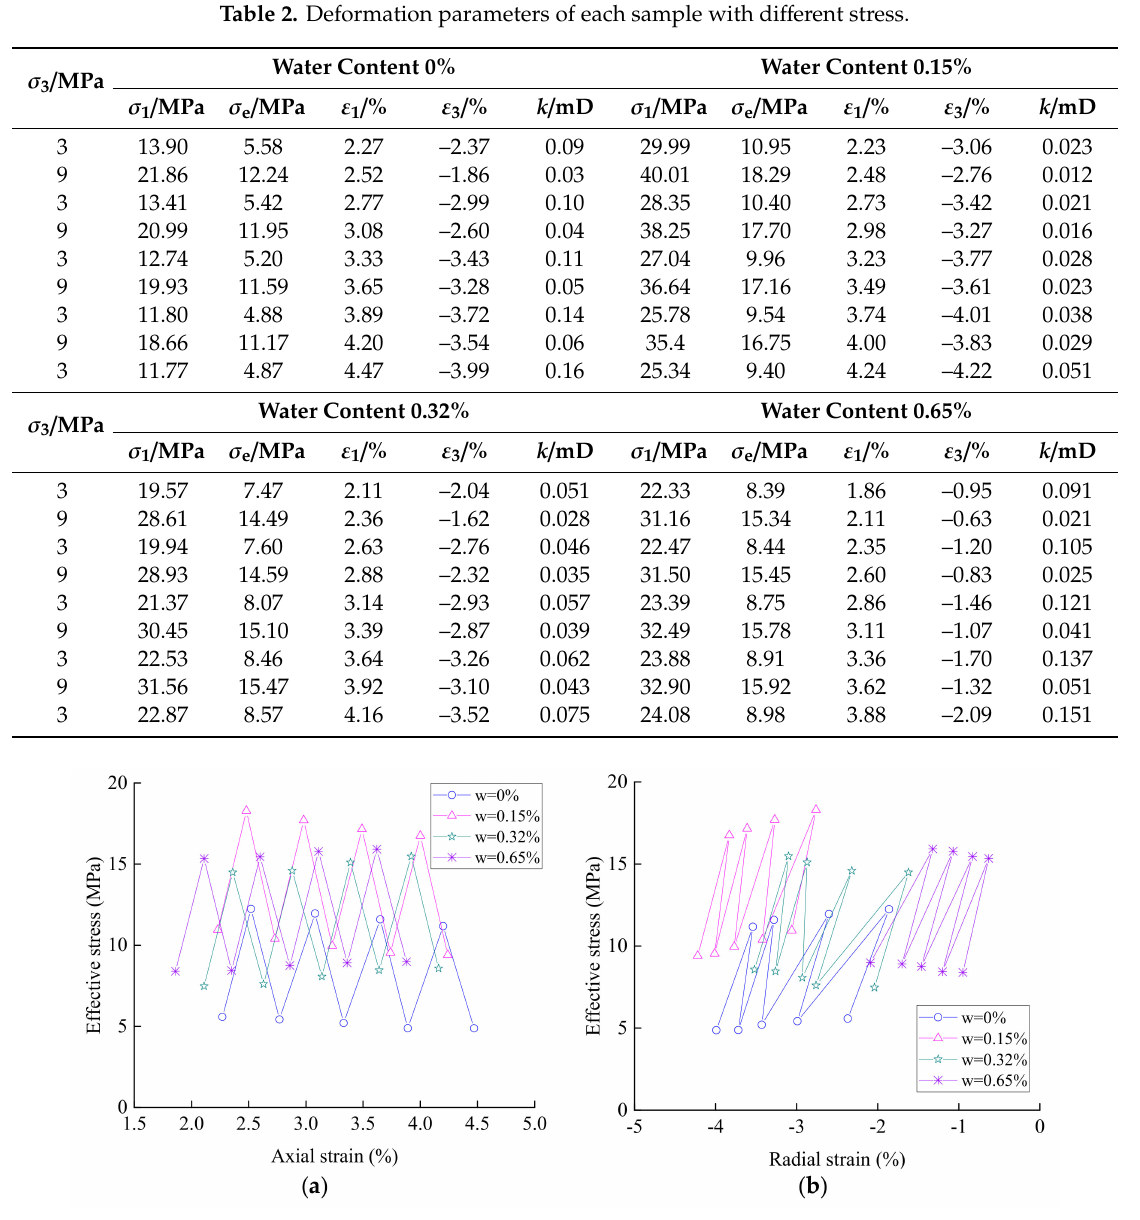
Figure 6. Axial strain-e ff ective stress and radial strain-e ff ective stress curves of specimens with di ff erent water content. ( a ) axial strain-e ff ective stress; ( b ) radial strain-e ff ective